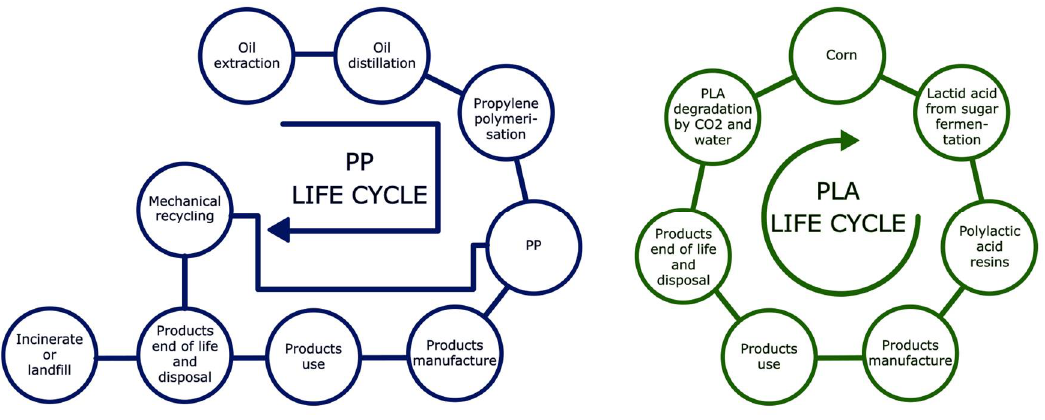
Figure 1. Simplified life cycle diagrams of polypropylene (PP) and poly(lactic acid) (PLA) resins used to manufacture consumer products.